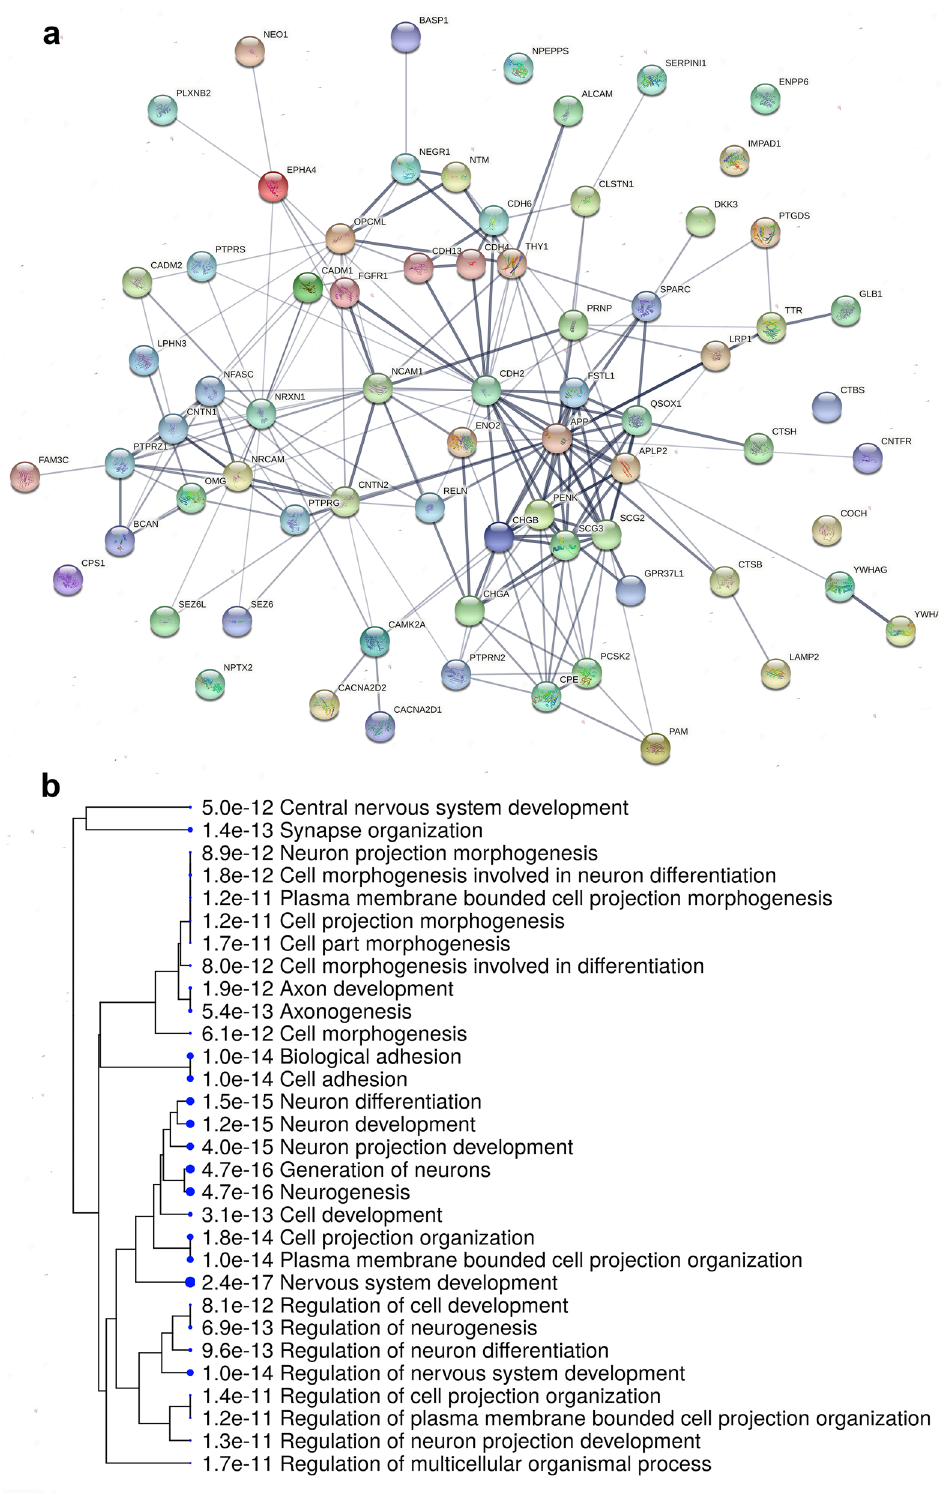
Figure 6. Protein–protein interactions (PPIs) and enriched pathways of 72 over-represented proteins in CSF compared to PL commonly in chicken, budgerigar and cockatiel. ( a ) STRING analysis of the protein interaction network showing associations of the proteins. Line thickness indicates the strength of data support (STRING version 11.0, http://strin g-db.org). ( b ) Hierarchical clustering tree summarizing the correlation among the significant pathways enriched in the 72 commonly over-represented CSF proteins across the three species. GO terms of biological functions revealed pathways related to neurogenesis and neuron differentiation. Pathways with many shared genes are clustered together and dot sizes indicate the degree of statistical significance (ShinyGO version 0.61, http://bioin forma tics.sdsta